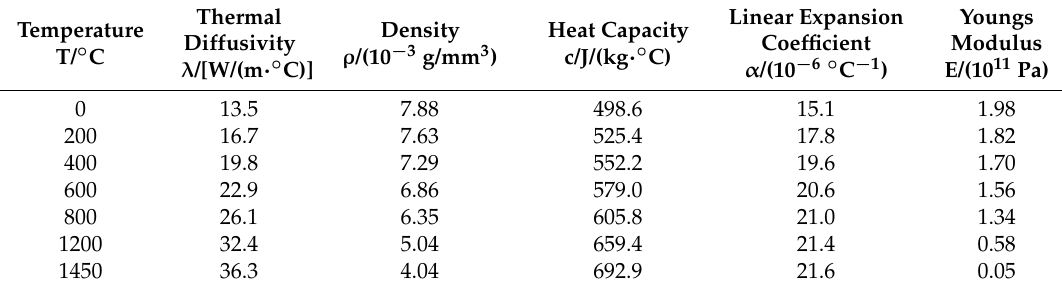
Table 1. Thermal physical properties of AISI 316L stainless